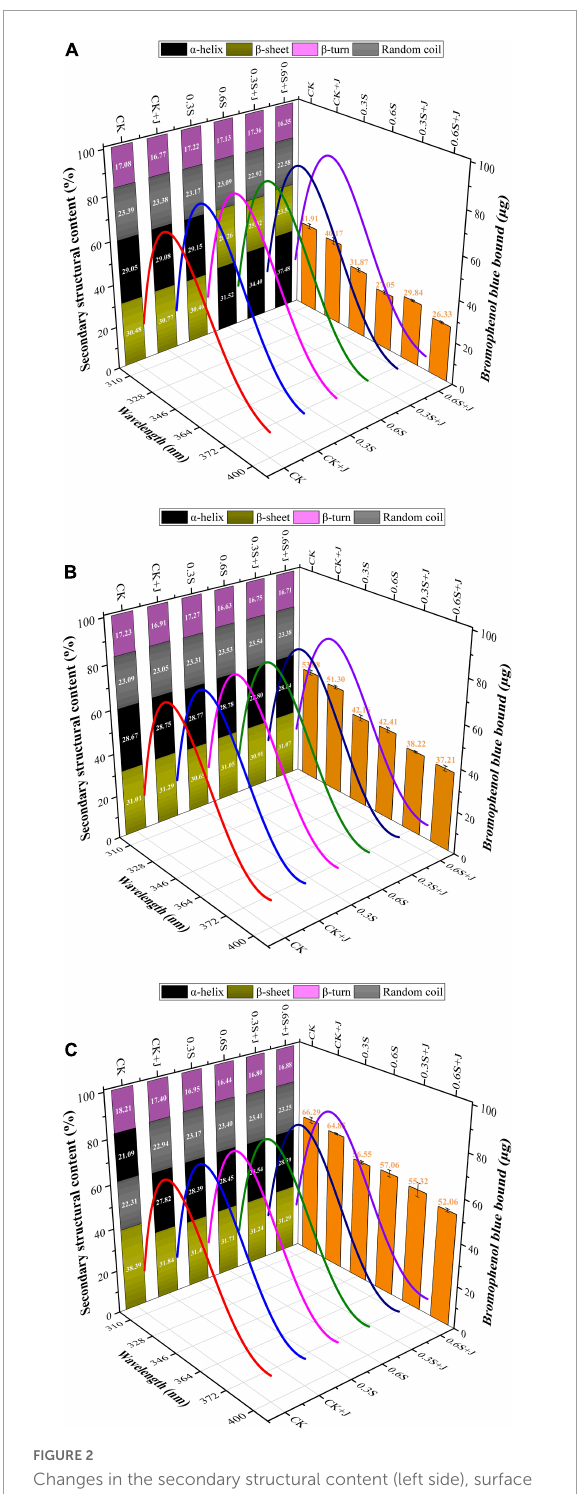
FIGURE2 Changes in the secondary structural content (left side), surface hydrophobicity (right side), and intrinsic fluorescence spectroscopy (3D Space) of post-mortem chicken myofibrillar protein from selenium yeast and jujube powder dietary supplements. (A) Conformation changes at post-mortem 0 h, (B) conformation changes at post-mortem 24 h, and (C) conformation changes at post-mortem 72 h.